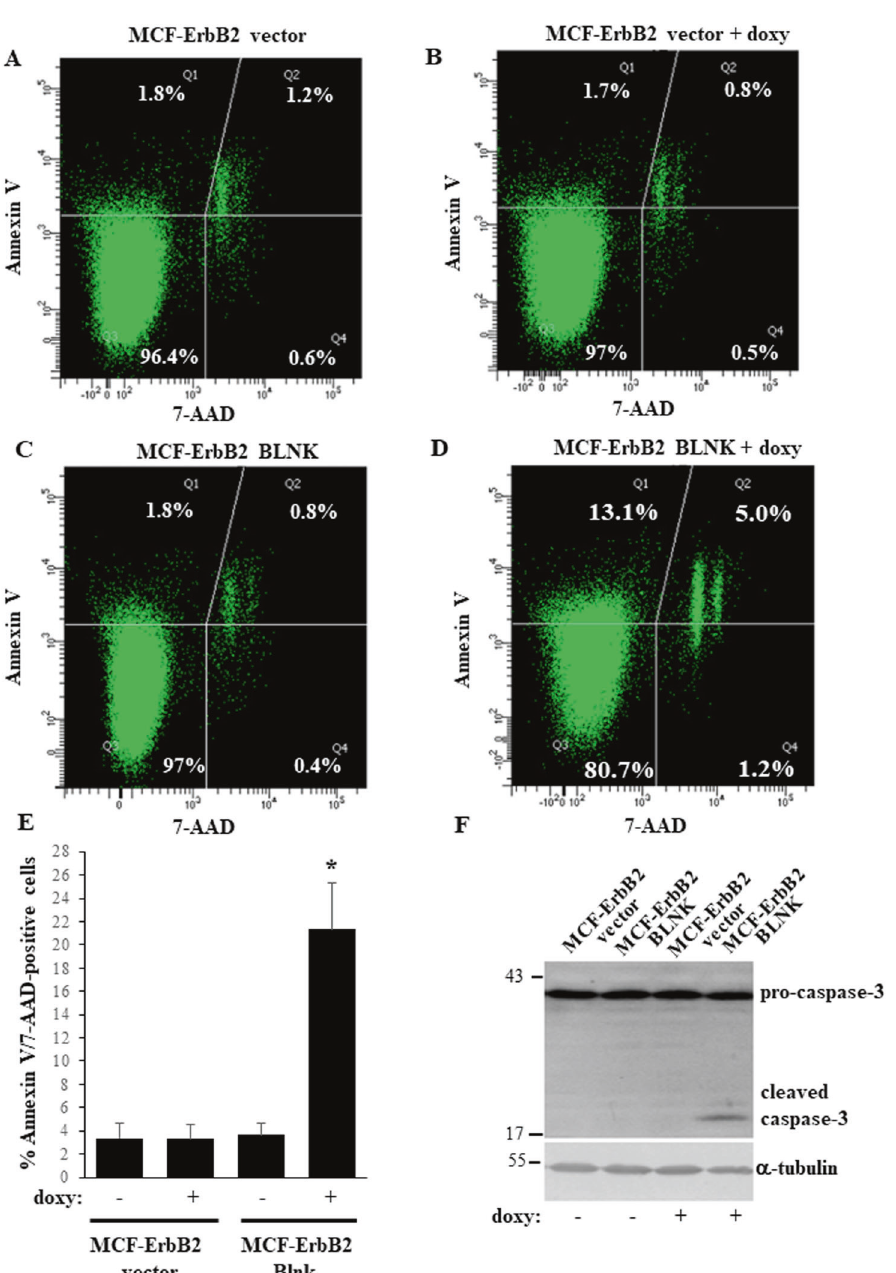
Fig. 5 BLNK triggers apoptosis of detached ErbB2-overproducing breast cancer cells. A – E Indicated cell lines were cultured detached form the ECM in the absence ( − ) or in the presence ( + ) of 3 ng/ml doxycycline (doxy) for 24 h and assayed for Annexin V binding and permeability to 7-AAD by fl ow cytometry. Representative fl ow cytometry plots are shown in A – D . % Annexin V- and 7AAD-negative (lower left quadrant), Annexin V-positive and 7AAD-negative (upper left quadrant), Annexin V-positive and 7AAD-positive (upper right quadrant) and Annexin V-negative and 7AAD-positive (lower right quadrant) cells in the total cell population is shown. Results of three independent experiments plus SD are shown in ( E ). % Annexin V-positive/7-AAD positive cells in E is the sum of the percentages of Annexin V-positive/7AAD-negative, Annexin V-positive/7AAD-positive and Annexin V-negative/7AAD-positive cells. * p -value < 0.05. F Indicated cell lines were cultured detached form the ECM in the absence ( − ) or in the presence ( + ) of 3 ng/ml doxycycline (doxy) for 48 h and assayed for caspase-3 expression. α -tubulin was used as a loading